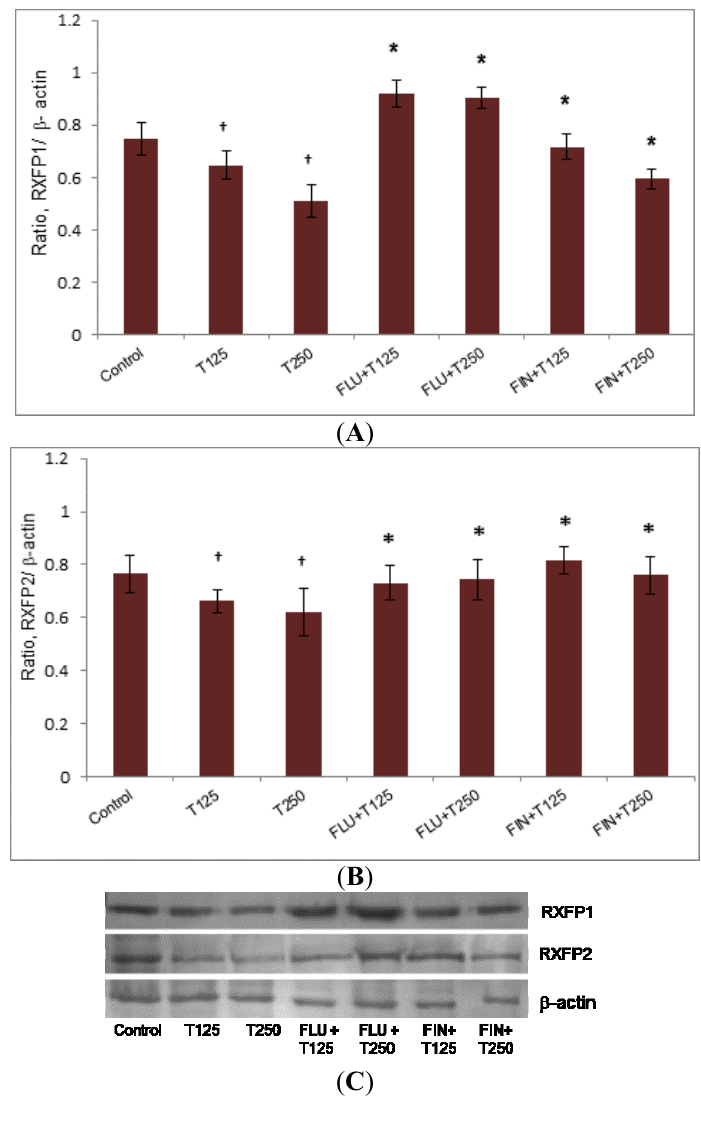
Figure 5. The expression of Rxfp1 ( A ) and Rxfp2 ( B ) protein from the homogenate of lateral collateral ligaments of ovariectomised rats treated with 125 and 250 μ g/kg testosterone with and without FLU and FIN administration. A dose-dependent decrease in Rxfp1